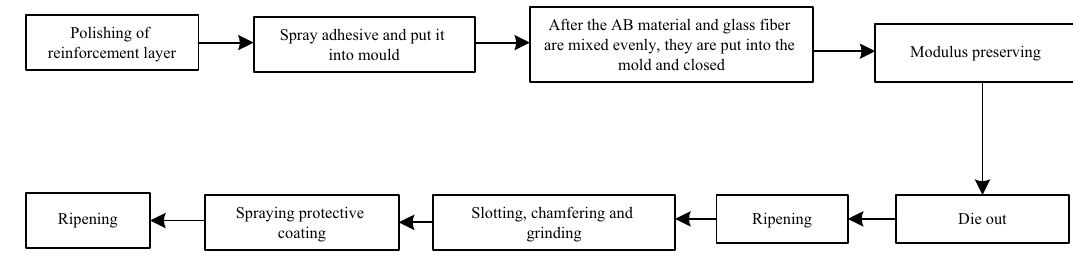
Figure 1: Structure optimization process of railway fl atcar loading equipment.